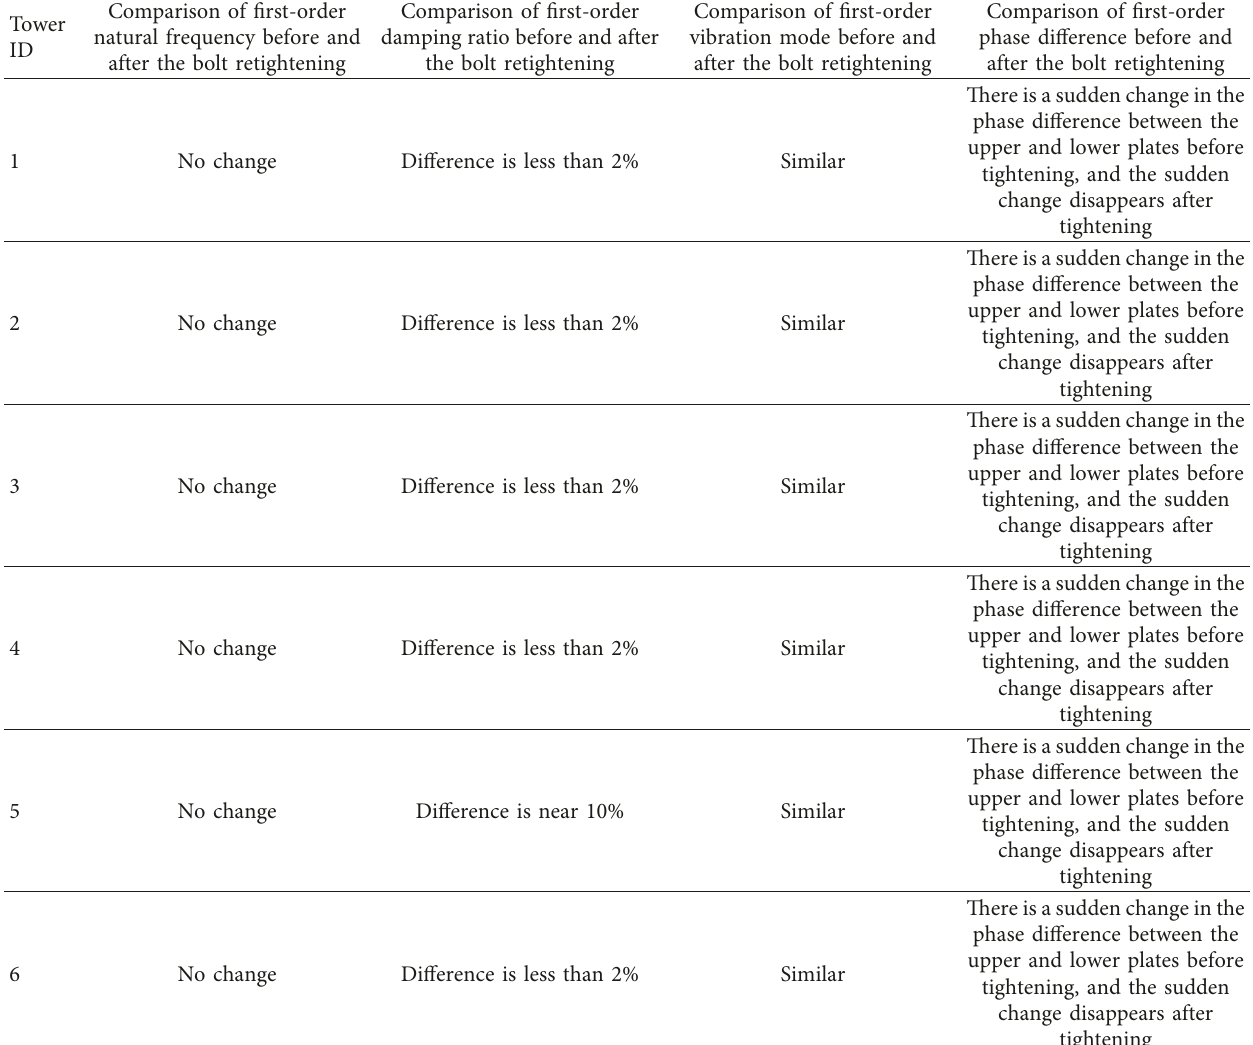
Table 6: Vibration characteristics before and after bolt tightening of the six wind turbine towers. Tower